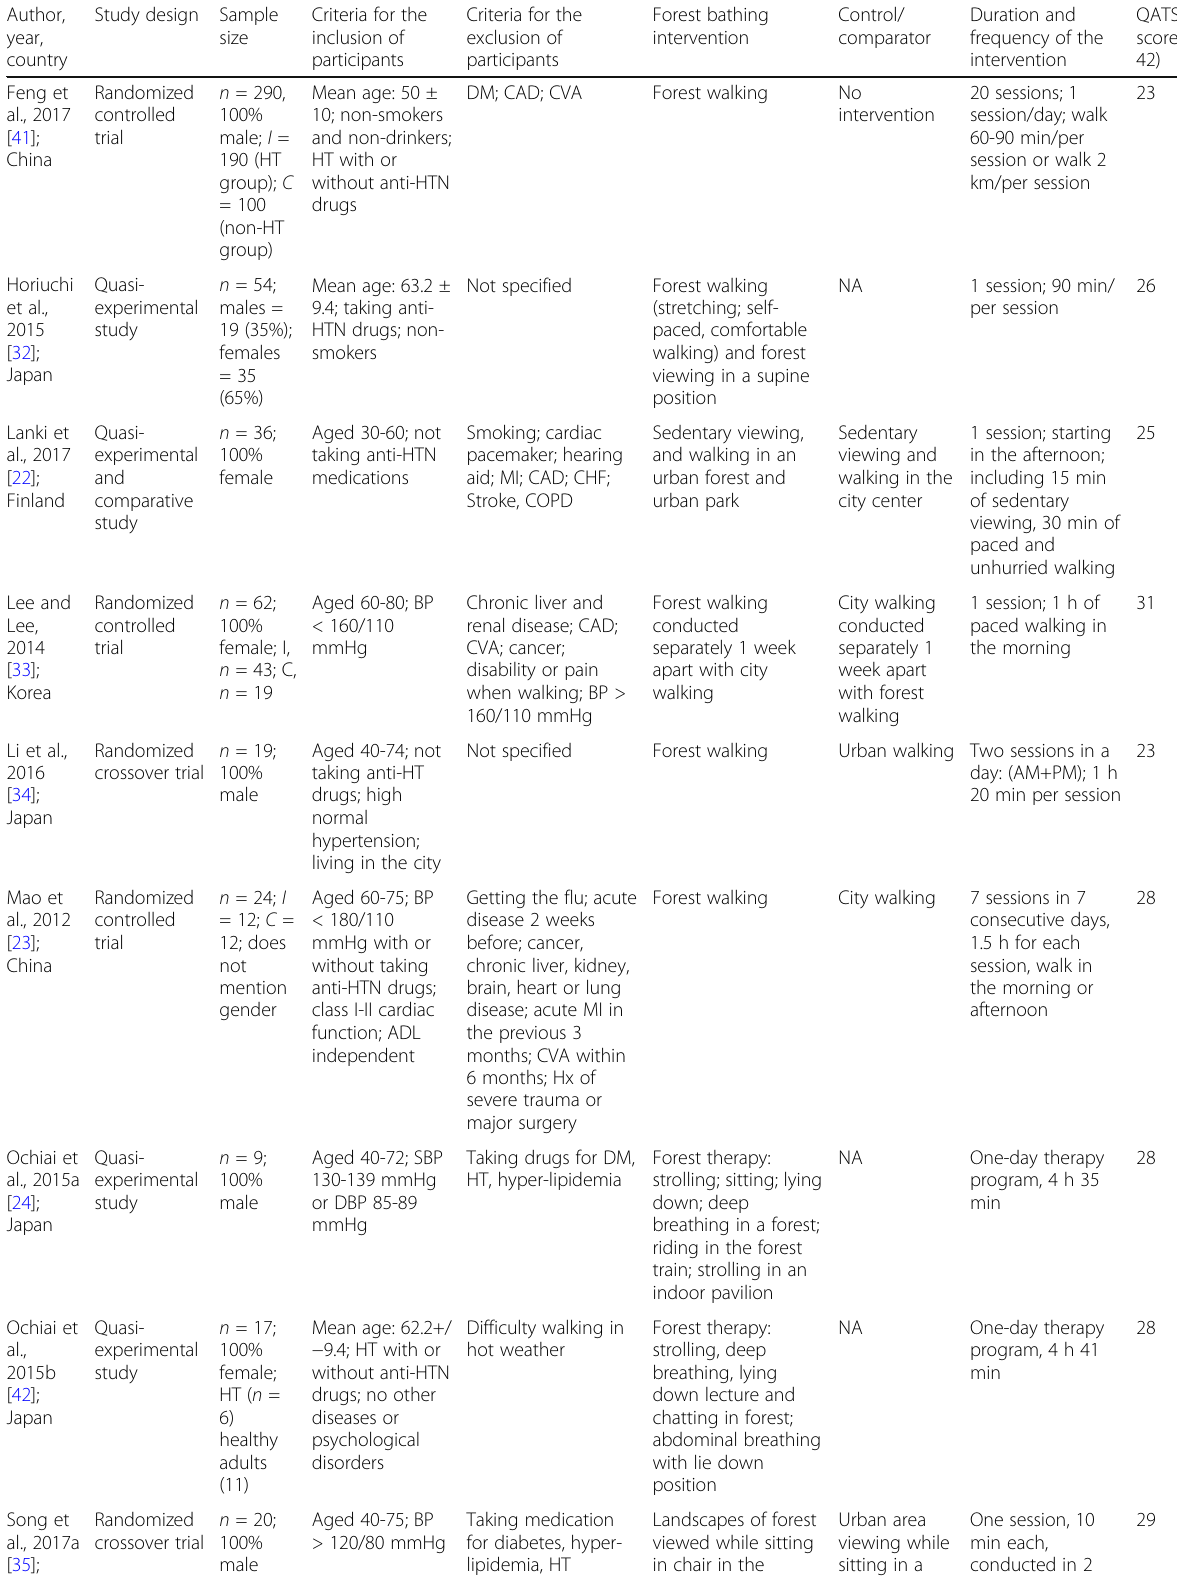
Table 1 Characteristics of the included